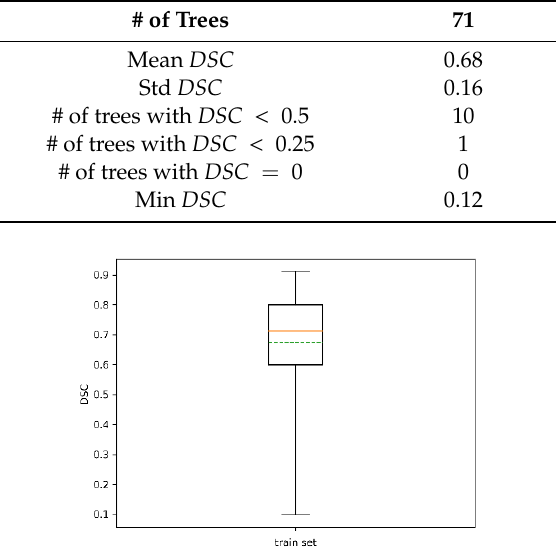
Figure 11. Boxplot of DSC for the training set. The dotted green line represents the mean.